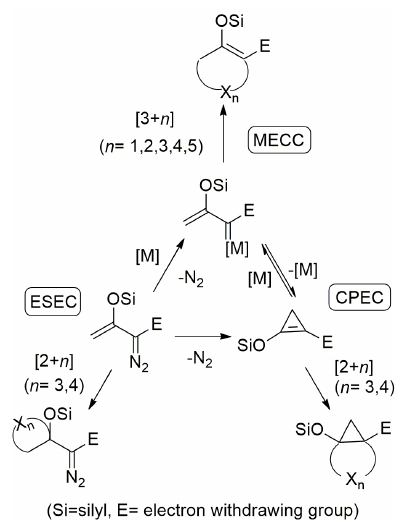
Figure 59 - Different cycloadditions pathways of enoldiazo compounds.